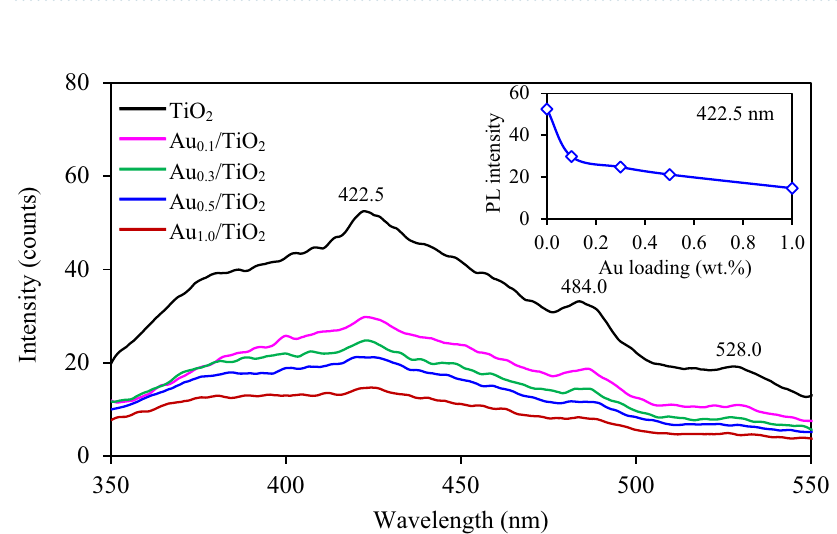
Figure 6. Representative photoluminescence spectra (PL) of commercial TiO 2 and Au x /TiO 2 NPs synthesized by photodeposition at different gold loadings in the range of 0.1–1.0